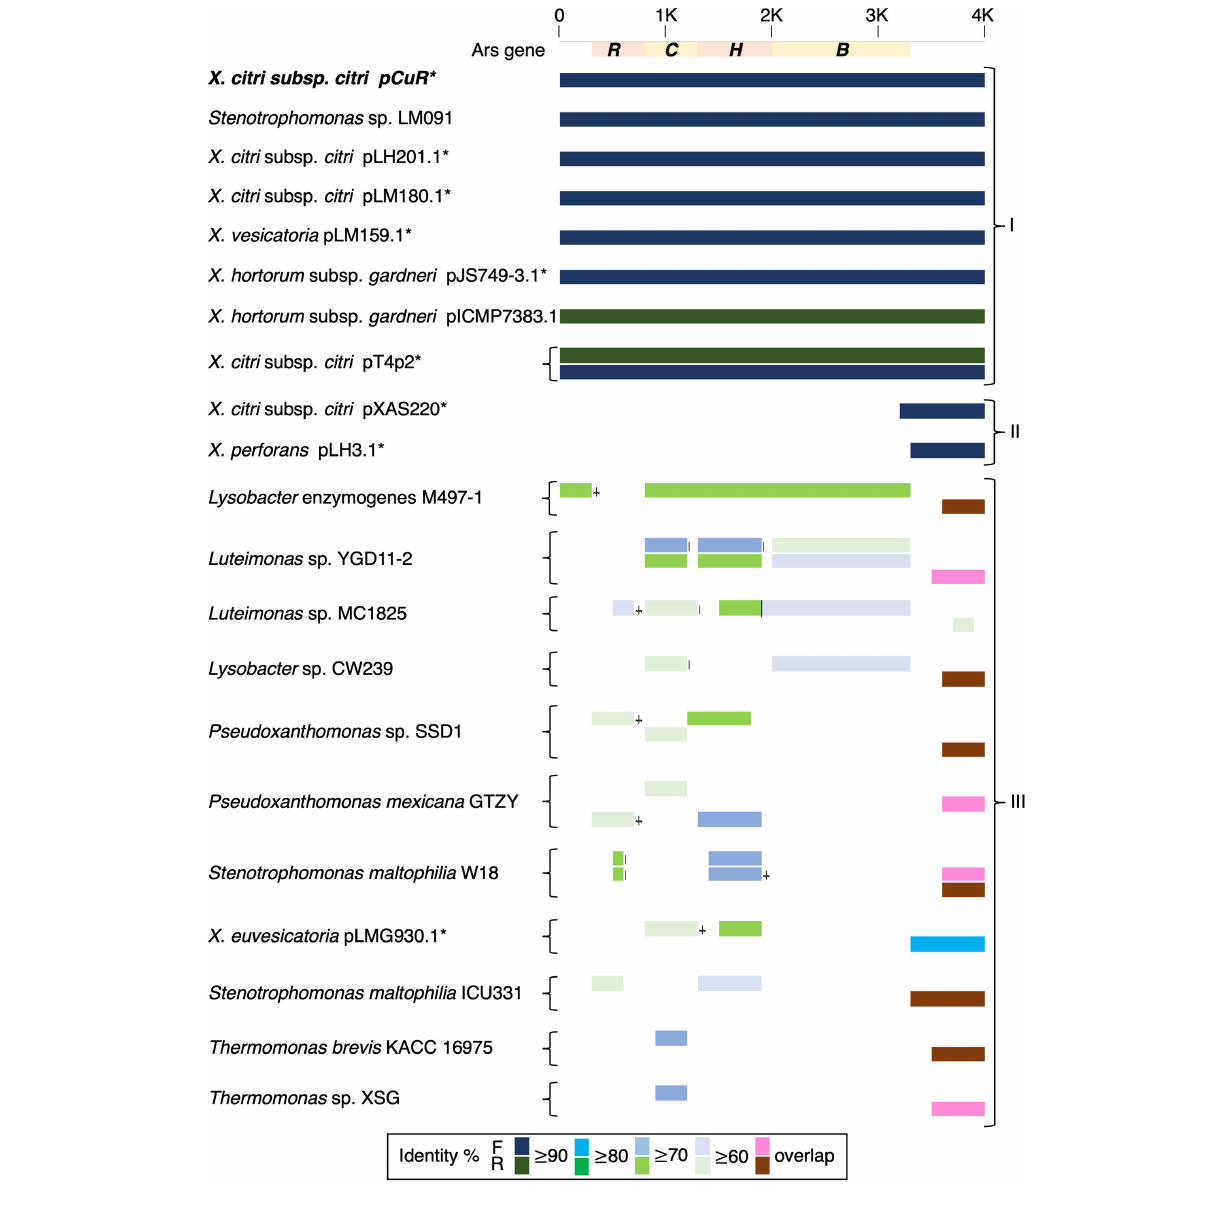
FIGURE 8 | Comparison of gene gain and loss in the arsenate resistance gene